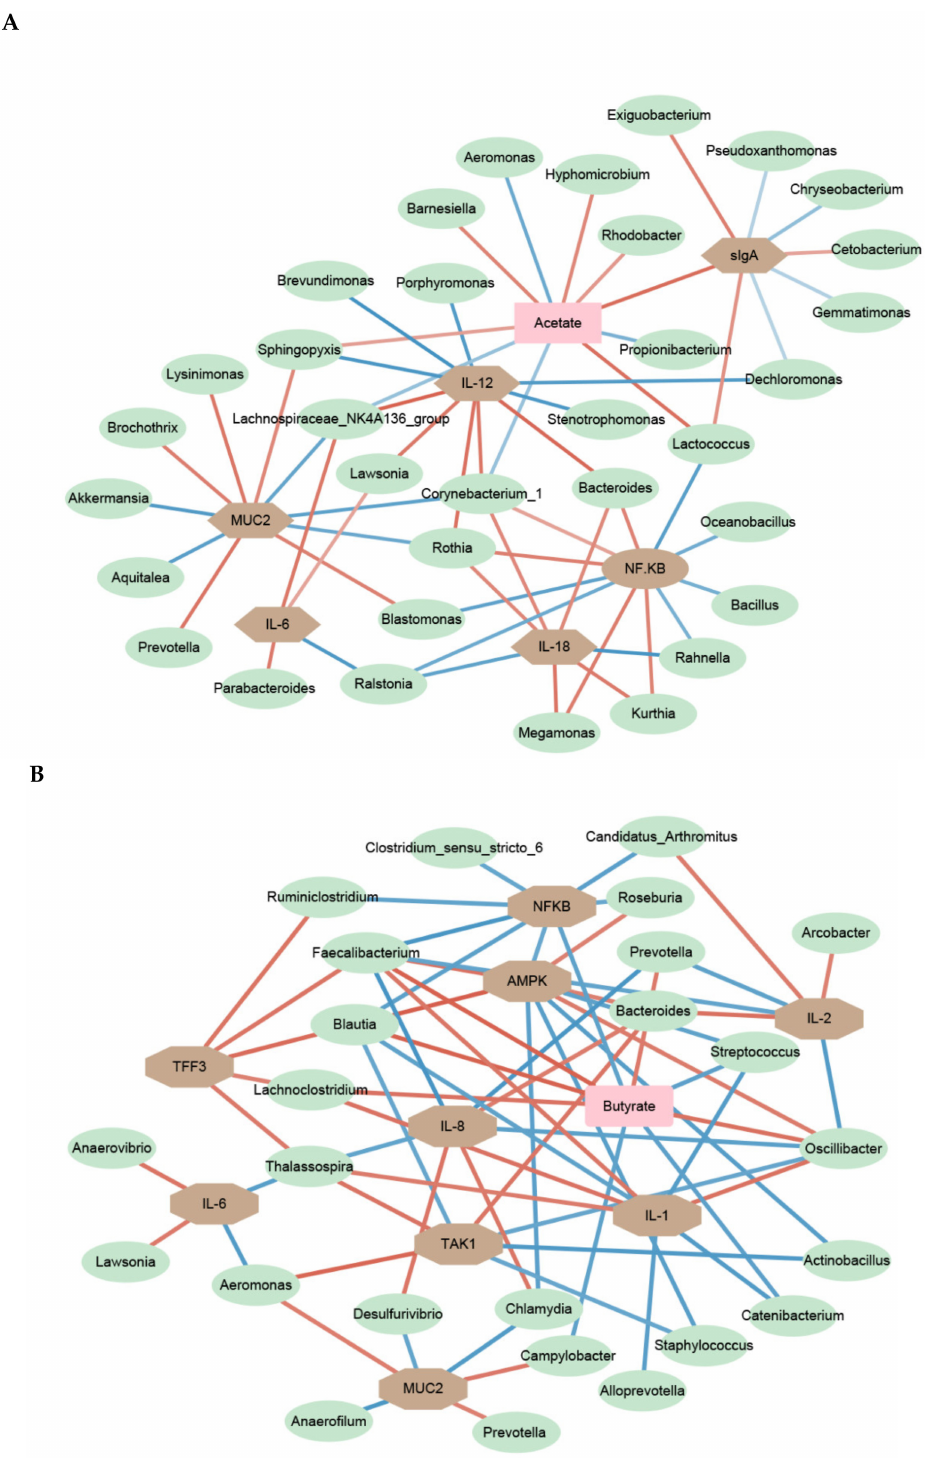
Figure 6. A network depicting correlations among cytokine contents, the relative abundances of bacterial genera, SCFA concentrations, gene expression, and sIgA concentrations in ileal ( A ) and cecal ( B ) mucosa of pigs using relevance networking. Only correlations with a partial spearman’s coe ffi cient > 0.7 and a p < 0.05 are shown. Bacterial nodes are OTUs labeled with their taxonomic classification, according to the SILVA database. The edge color intensity indicates the level of the association: red, positive; blue, negative. Node shape indicates whether it is the mucosal immune (octagon), SCFAs(rectangular), or genera